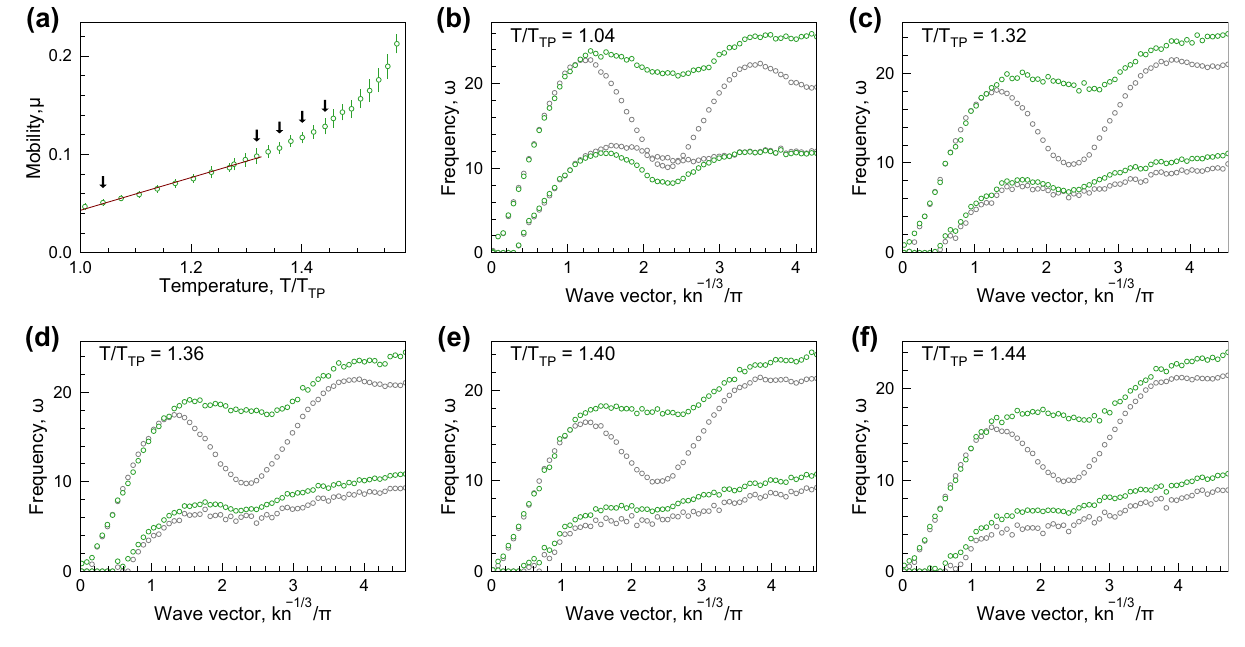
Figure 8. Particle mobility and dispersion relations: The results for LJ16-6 potential, description is the same as in Fig.